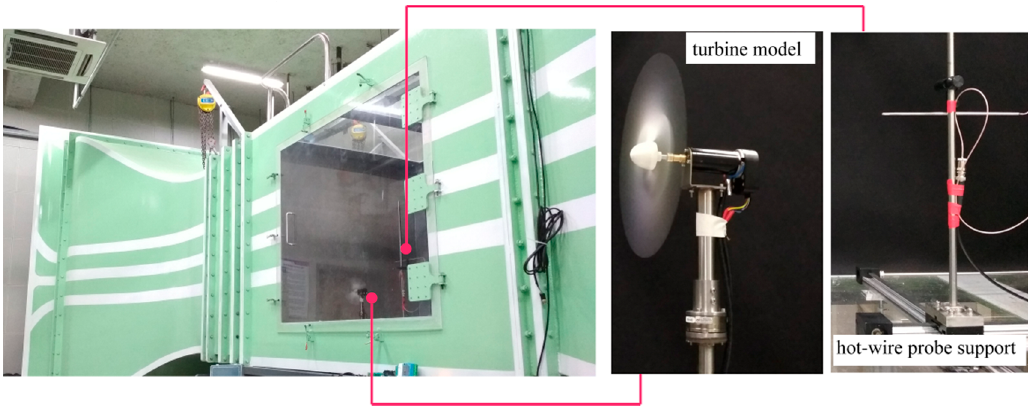
Figure 1. Photograph of the test section of the wind tunnel in Tsinghua University.